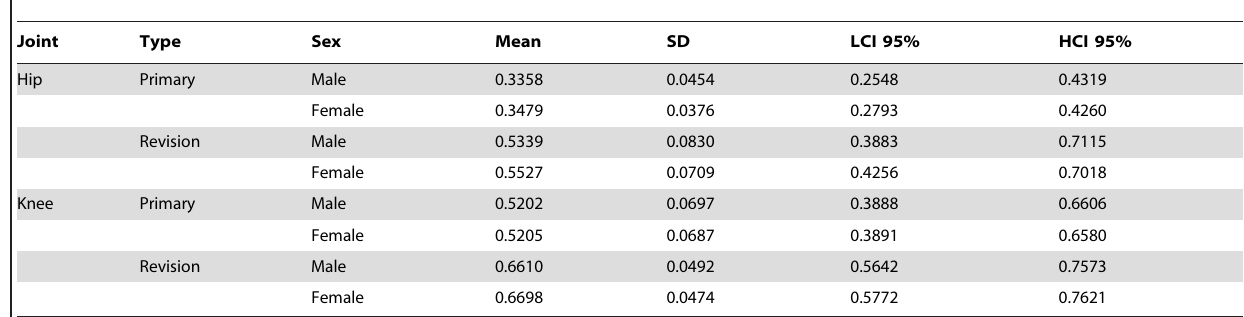
Table 3. Effect size of hip and knee replacements on